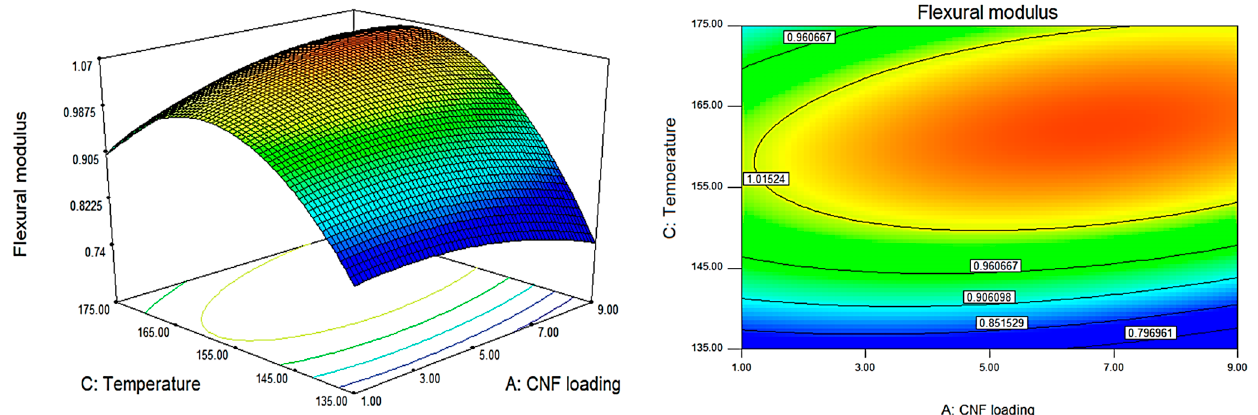
Figure 3. The 3D and response surface contour plots for the dependence of P(HB- co -11% HHx)/CNF bionanocomposite’s flexural strength on CNF loading and rotational speed as significant factors.